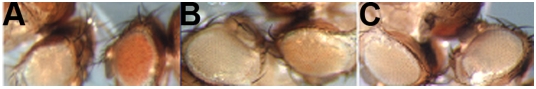
Suppression of TPE.A) Strong (+++) suppression of TPE by the Su(z)25 allele. w
−/Y; reporter gene/CyO (left), and w
−/Y; reporter gene/Su(z)2
5 sibling (right). B) Weak (+) suppression of TPE by the Su(z)2De26 allele. w
−/Y; reporter gene/CyO (left), and a w
−/Y; reporter gene/Su(z)2De
26 sibling (right). C) Hp1a mutations have no effect of TPE. w
−/Y; reporter gene/CyO (left), and w
−/Y; reporter gene/Hp1a sibling (right) have identical pale yellow eyes.